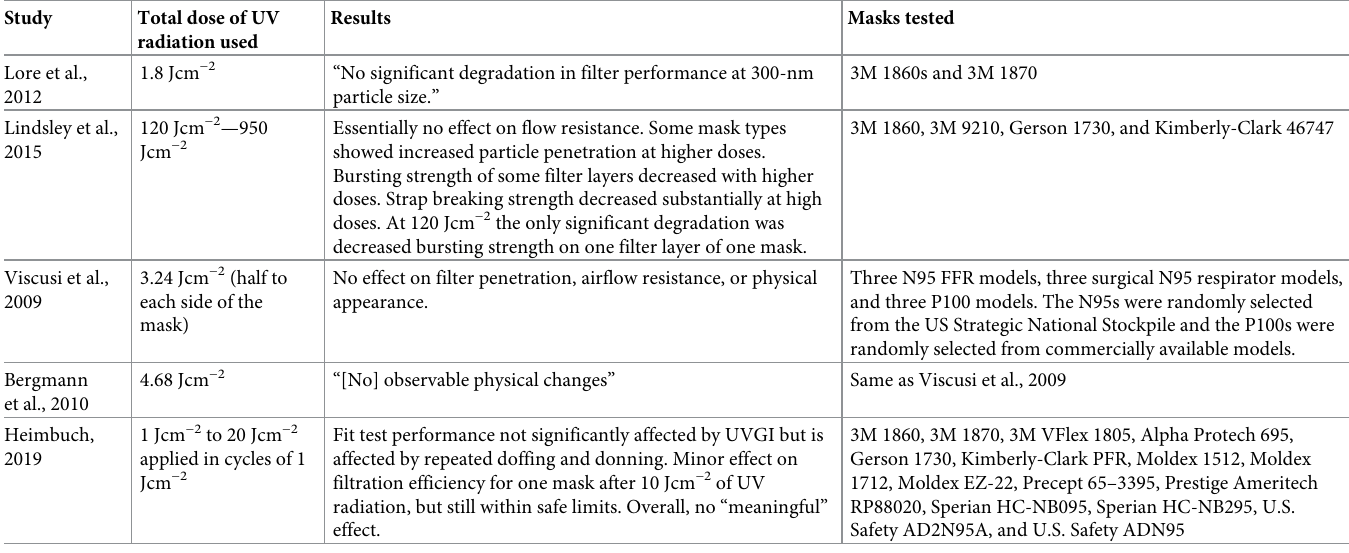
Table 1. Key findings from research on UV-mediated mask